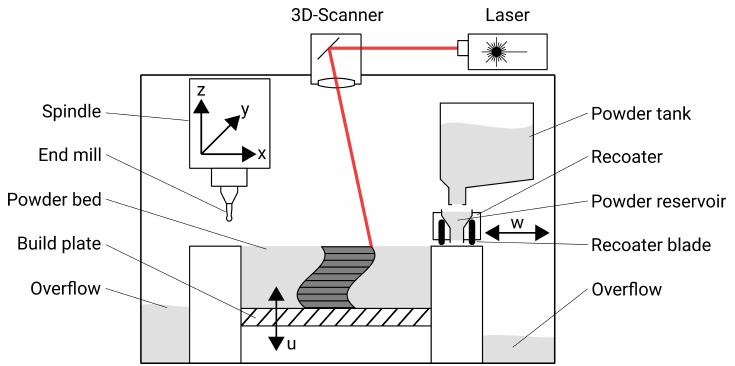
Figure 1. Schematic illustration including movable axes of the hybrid additive manufacturing (AM) machine used in this